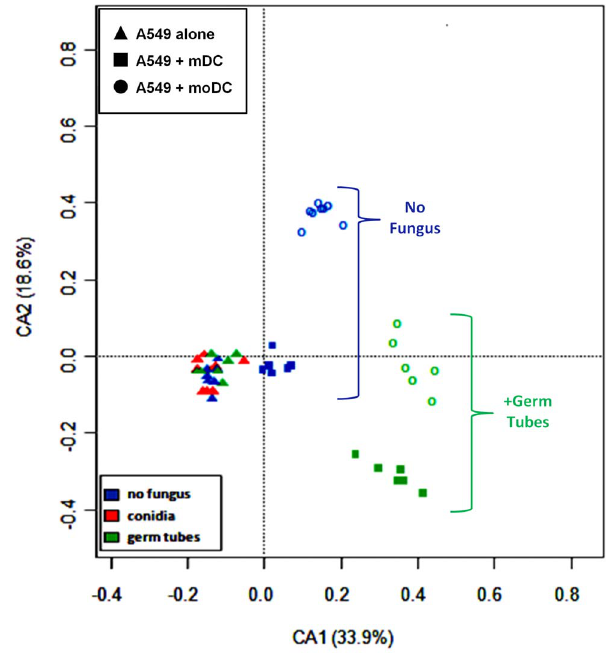
Figure 1. Correspondence analysis indicating the factors with the greatest influence on the microarray data. The triangles represent the A549 cells and these clustered closely even in the presence of A. fu migatus germ tubes. Whereas mDC, represented by squares, clustered close to the A549 data except when germ tubes were added which caused a distinct cluster to be formed. The moDC, represented by circles, formed two distinct clusters one consisting of datasets without fungus. The second cluster for datasets with germ tubes was closer to the mDC dataset with germ tubes. These data indicate that including moDC with the A549 layer leads to greater changes in gene expression compared to the A549 layer than in the absence of exogenous immunostimulators such as A. fumigatus . The data indicate that conidia are not strong immunostimulators of A549 cells. The addition of germ tubes caused similar gene expression responses when mDC or moDC were present.